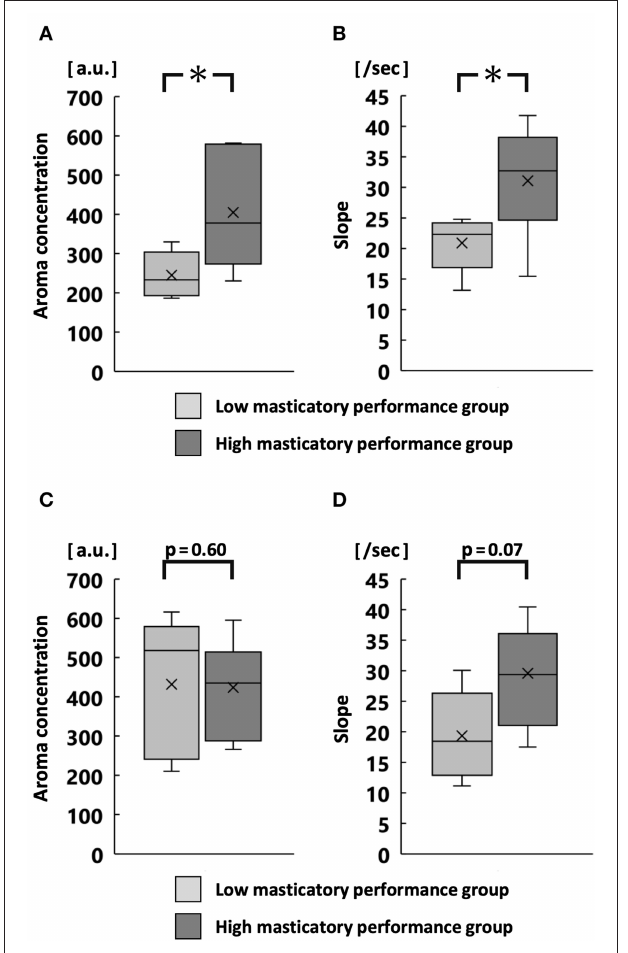
FIGURE 5 | Maximum aroma concentration and slope at 30 strokes (A,B) and at chewing strokes equal to 100% of swallowing threshold (C,D) . * p < 0.05.